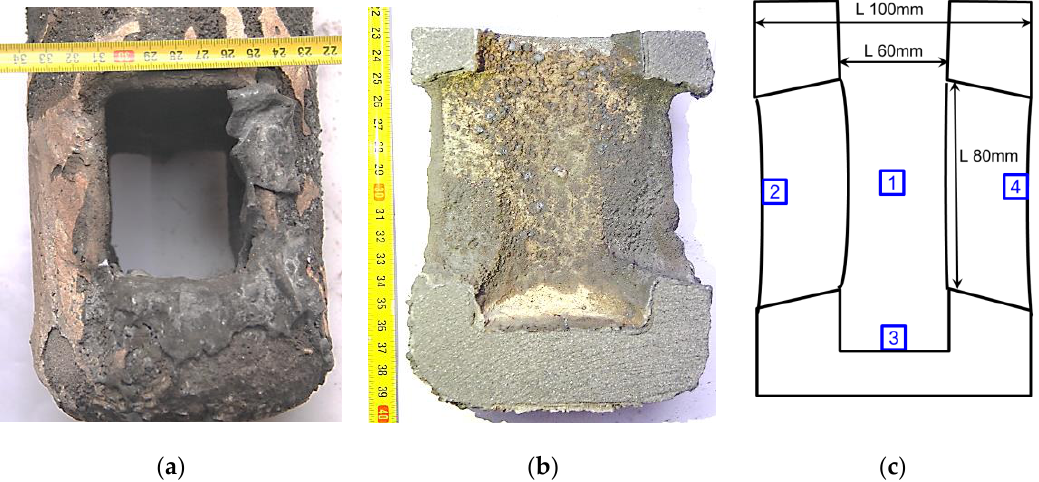
Figure 1. Image of the SEN clogging and schematic sampling locations. ( a ) outside morphology, ( b ) inside morphology, ( c ) schematic.